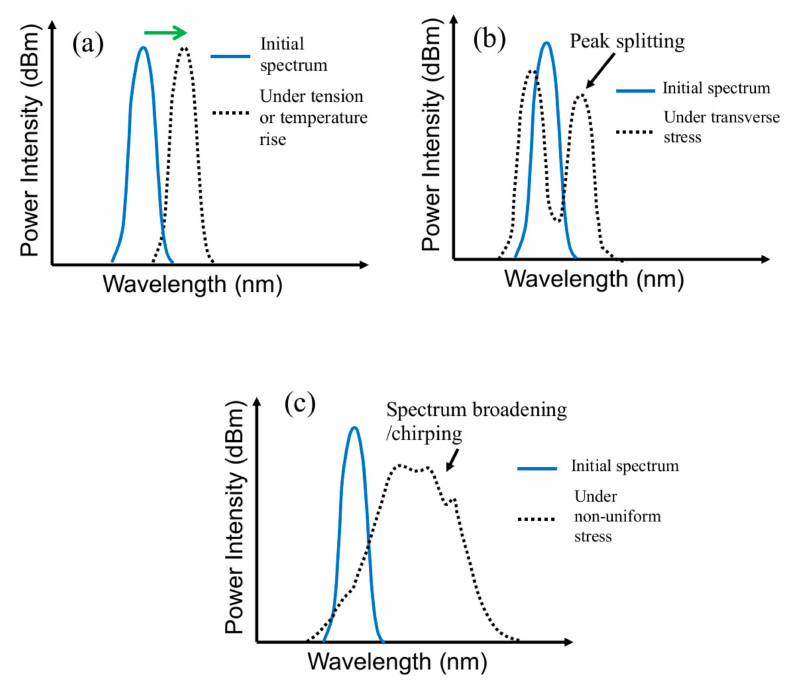
Figure 1. Schematic diagram to show FBG spectrum changes under ( a ) tensile stress or temperature rise; ( b ) transverse stress and ( c ) non-uniform stress along its